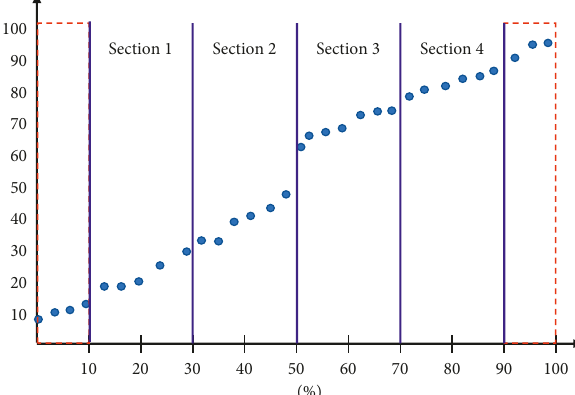
Figure 15: Interval-based average